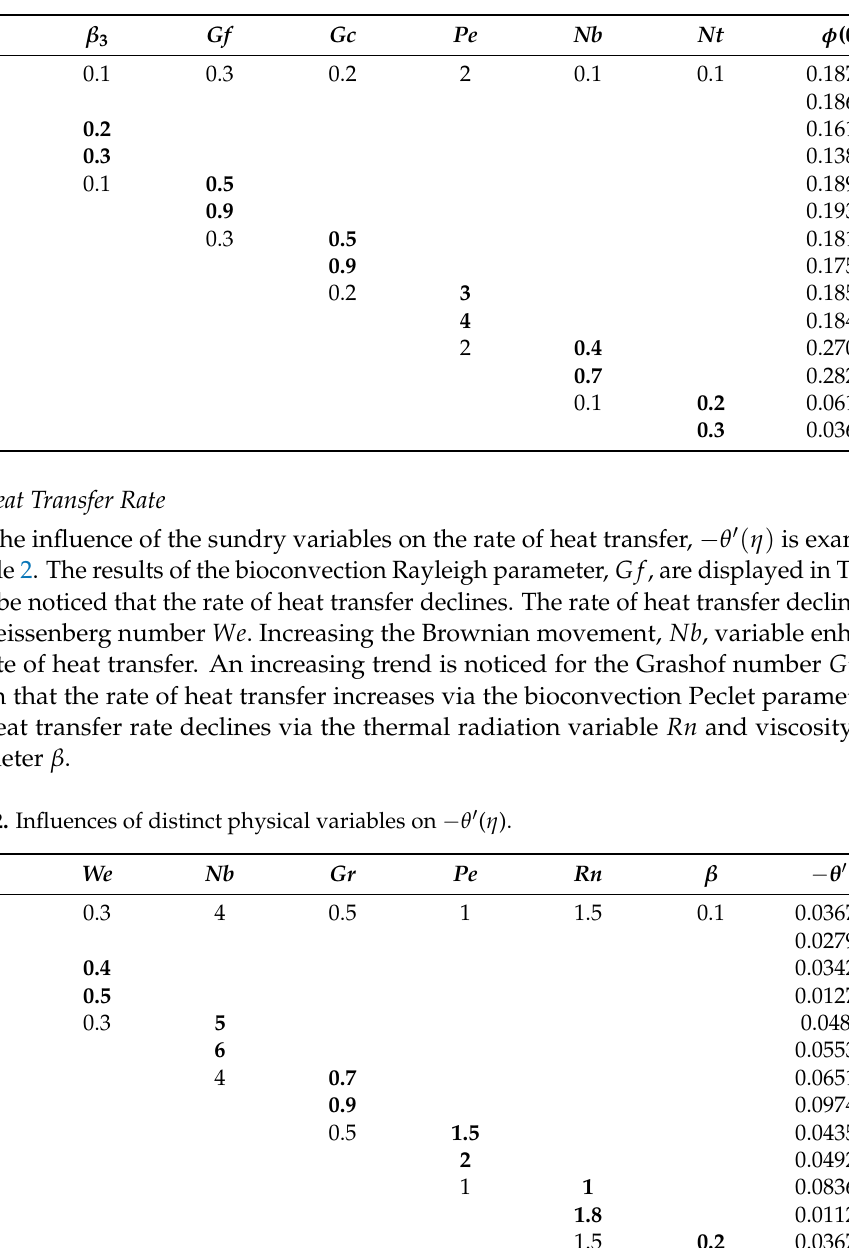
Table 1. Influences of distinct physical variables on φ (0).